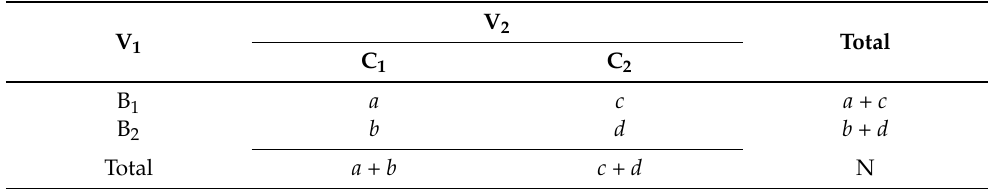
Table 1. Example of a 2 × 2 contingency